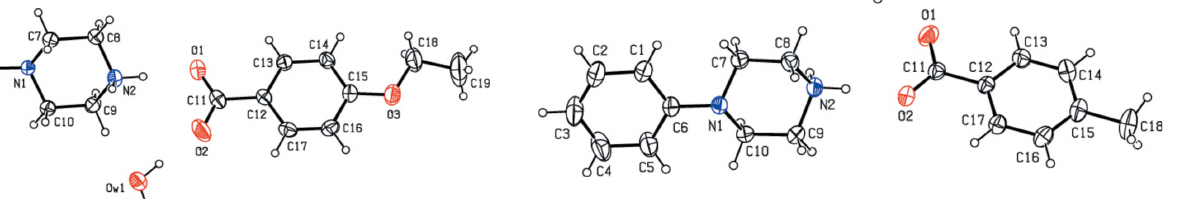
Figure 3 The independent components of compound ( III ) showing the atom- labelling scheme. Displacement ellipsoids are drawn at the 30% probability level.